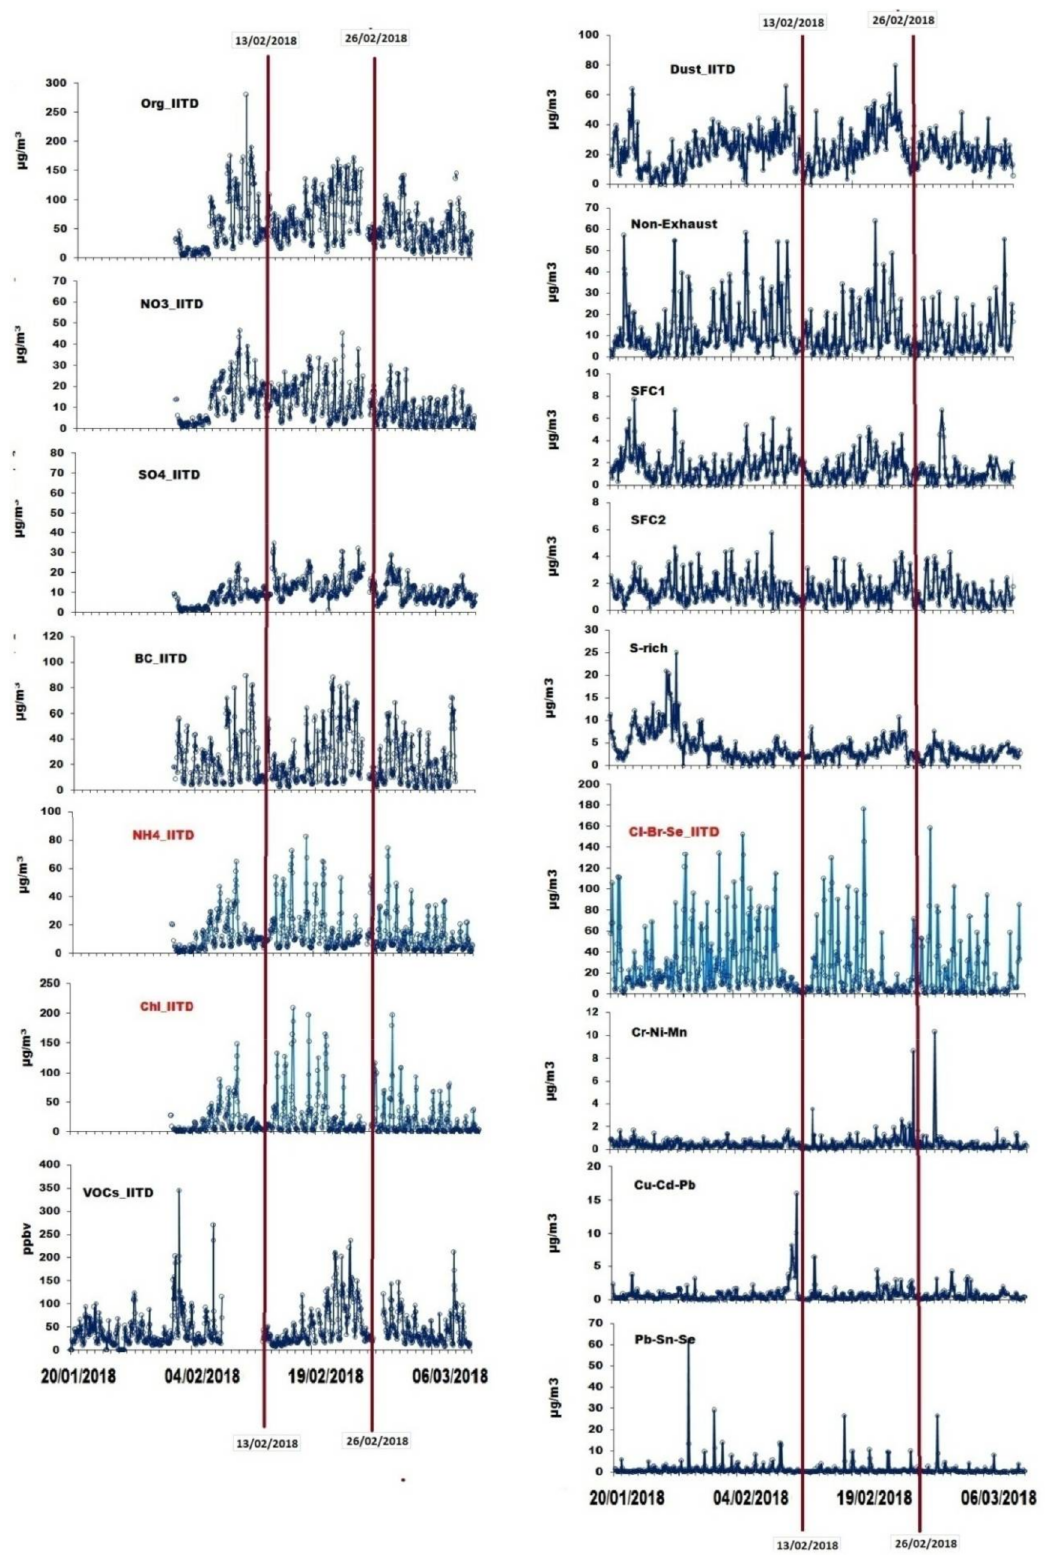
Figure 4. Time series of particulate OA, NO3, BC, SO4, NH4, Chl, gaseous VOCs, and nine factors of elements at the IIT Delhi site for the span of the study period from Lalchandani et al., Wang et al. and Rai et al. [10,12,13]. Vertical red lines indicate the phase of gradual changes in all pollutants during the two-week period of 13–26 February